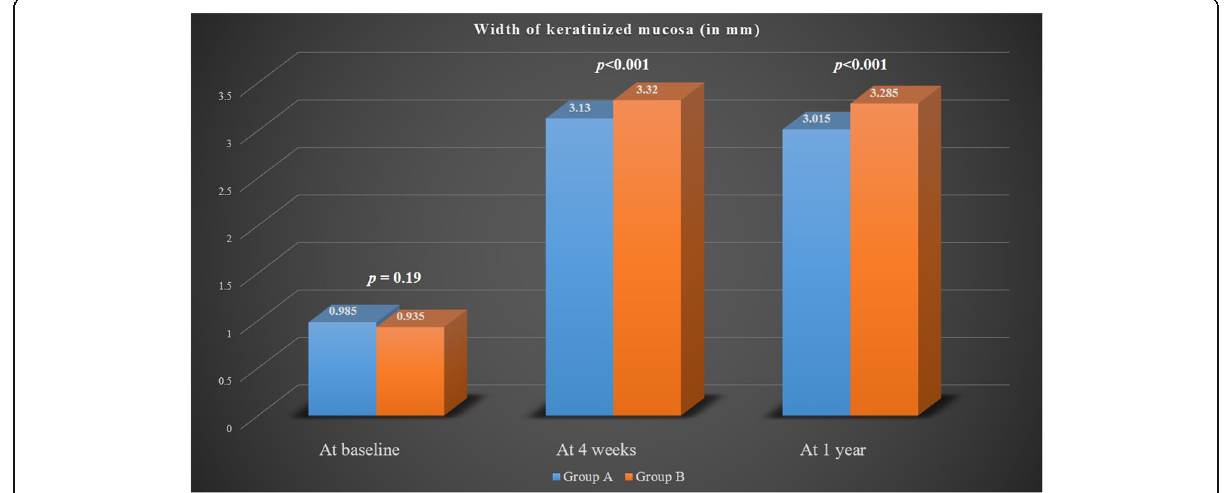
Fig. 4 Comparison of the width of keratinized mucosa between group A and group B at various time